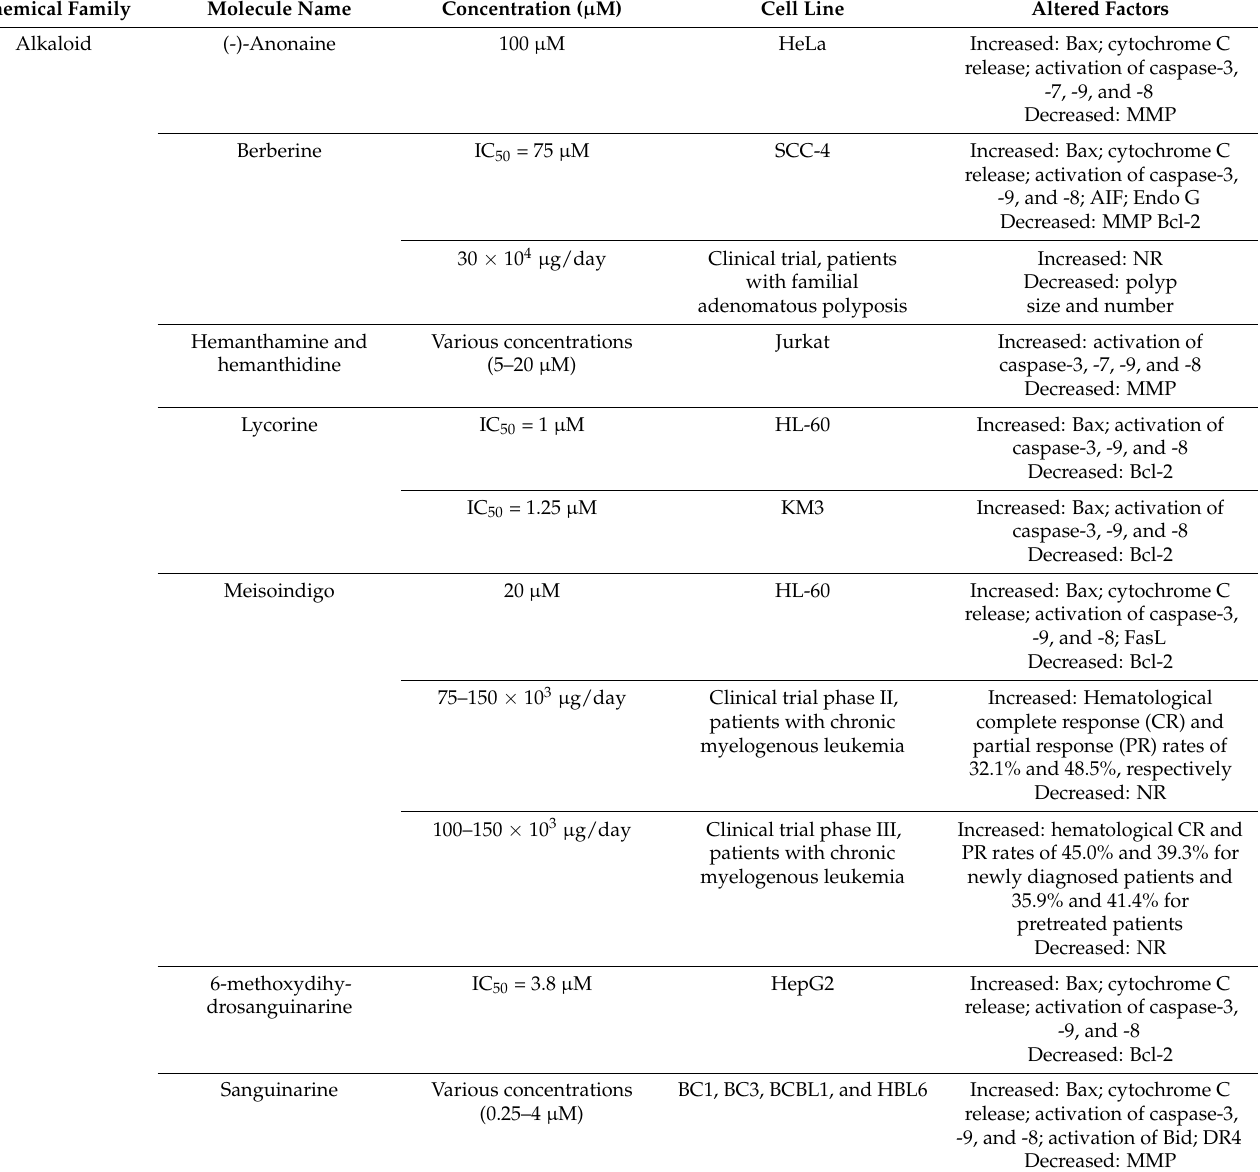
Table 2. Phytochemicals with the ability to induce both pathways of